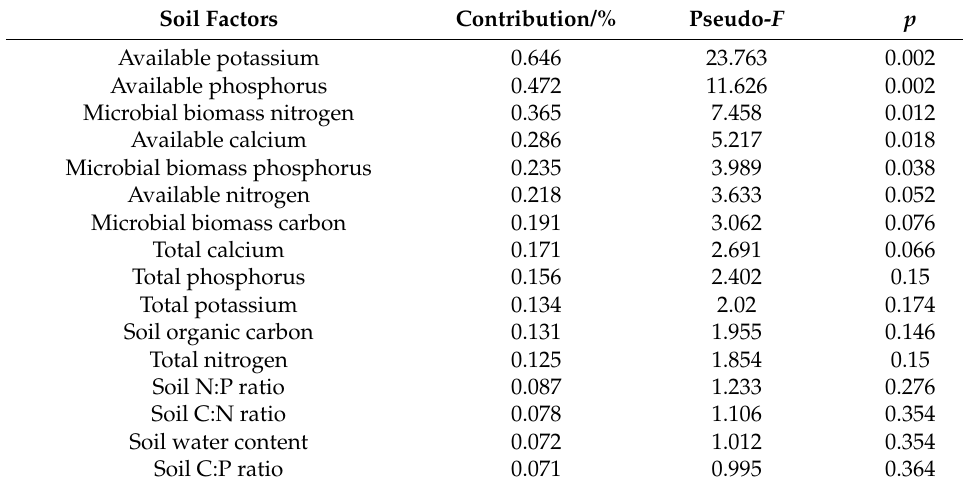
Figure 2. Redundancy analysis of free amino acids and soil. SWC, soil water content; SOC, soil organic carbon; TN, total nitrogen; TP, total phosphorus; TK, total potassium; TCa, total calcium; AN, available nitrogen; AP, available phosphorus; AK, available potassium; ACa, available calcium; MBC, microbial biomass carbon; MBN, microbial biomass nitrogen; MBP, microbial biomass phosphorus; Val, valine; Thr, threonine; Phe, phenylalanine; Met, methionine; Leu, leucine; Lys, lysine; Iso, isoleucine; His, histidine; Arg, arginine; Ser, serine; Pro, proline; Gly, glycine; Glu, glutamate; Asp, aspartate; Ala, alanine; Tyr, tyrosine; Cys, cystine. Table 8. Importance sequencing and significance test of soil